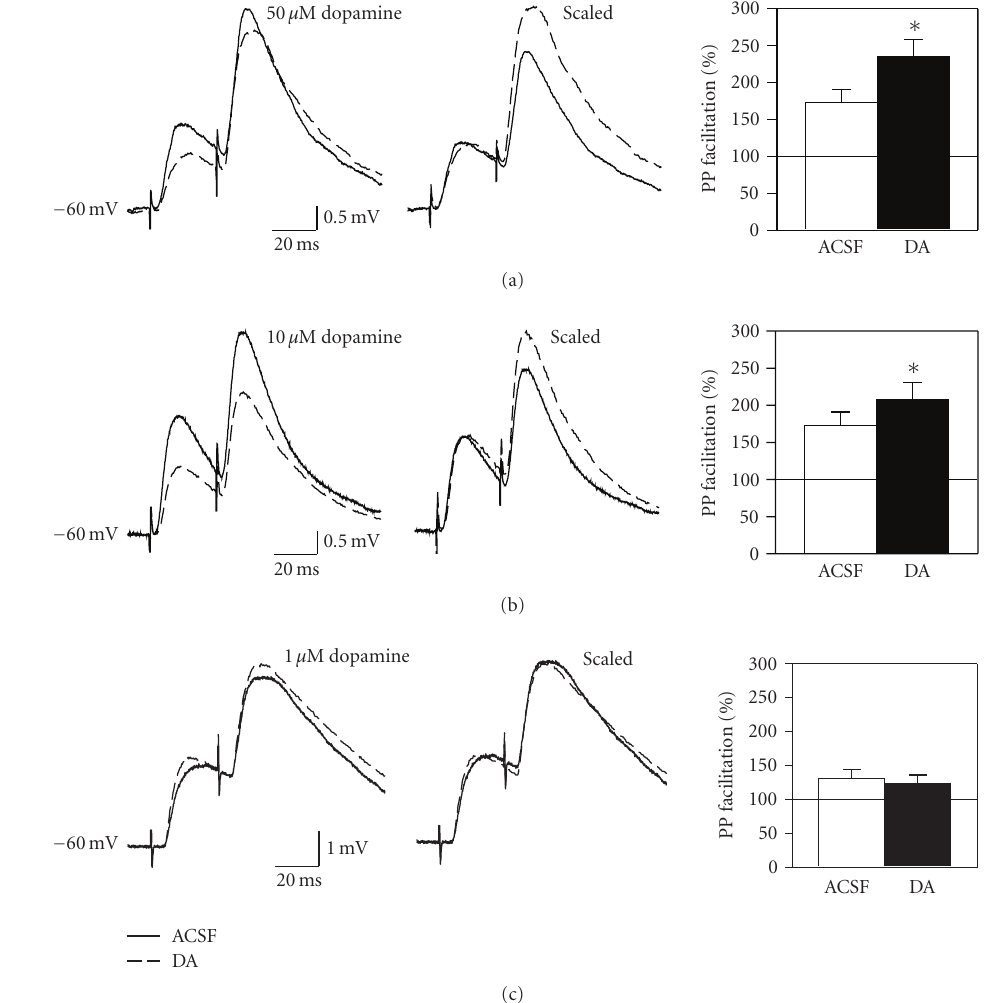
Figure 2: High concentrations of dopamine increase paired-pulse facilitation. (a) Pairs of stimulation pulses with a 30 millisecond interpulse interval were delivered before and after 5-minute bath application of 50 μ M dopamine. Averaged traces at left show responses recorded before (ACSF) and after (DA) dopamine from a representative cell. Note the suppression of the response to the first pulse and the large facilitation of the second response following dopamine (dotted line). Traces at right have been scaled to the amplitude of the first response in normal ACSF to aid comparison. Group data are shown on the right. (b) Paired-pulse facilitation was also enhanced by 10 μ M dopamine. (c) In contrast, the low concentration of 1 μ M dopamine does not a ff ect paired-pulse